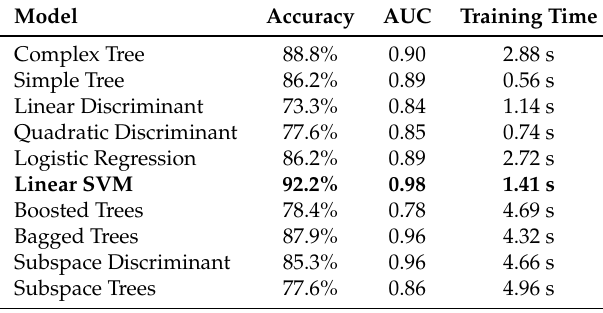
Table 2. Comparison of Accuracy, Area Under Curve and Training Time for different